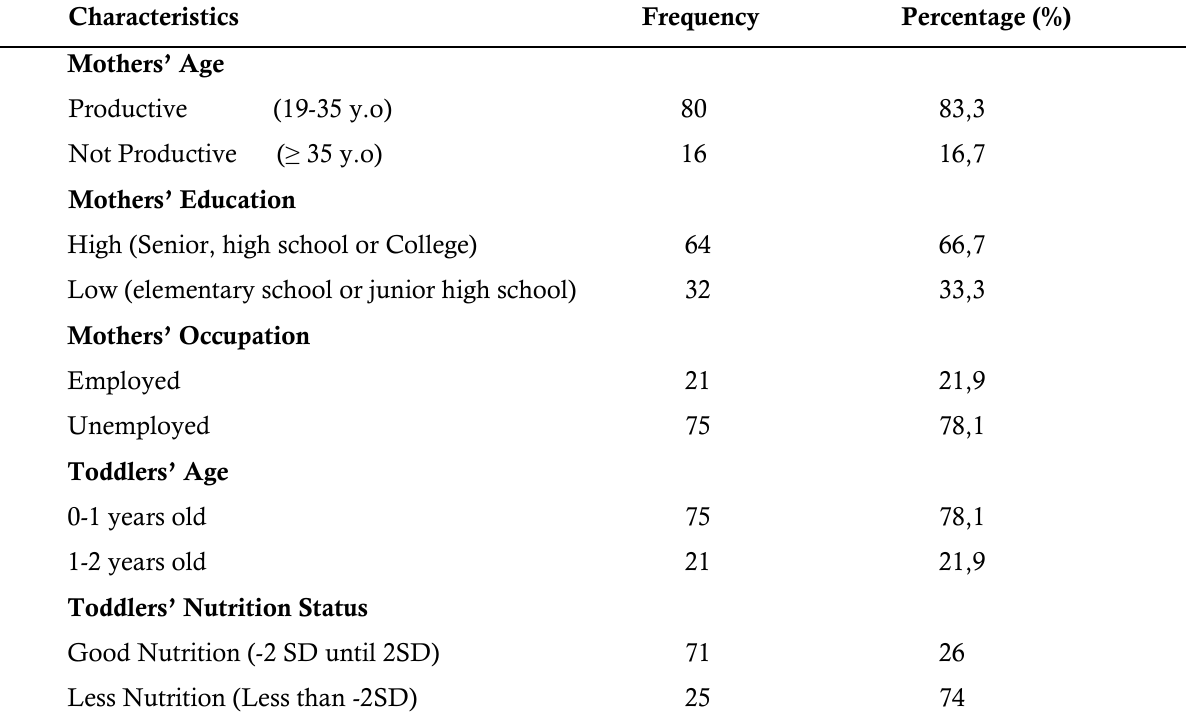
Table 1. Frequency Distribution of Respondents Characteristics